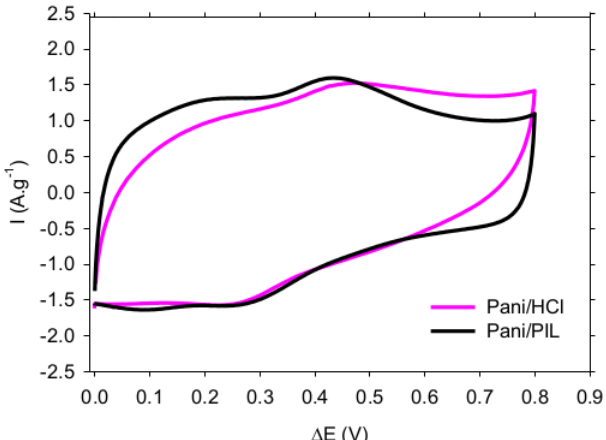
Figure 2. CV curves at a scan rate of 15 mV · s − 1 of PANI/HCl and PANI/PIL electrodes in H 2 SO 4 1 mol · L − 1